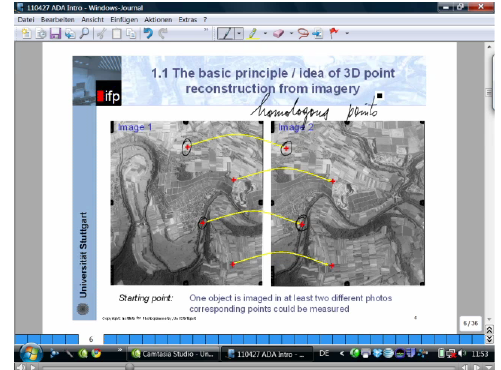
Figure 10: Lecture on Airborne Data Acquisition including annotations http://www.ifp.uni-stuttgart.de/lehre/vorlesungen/geo-airborne/110427-